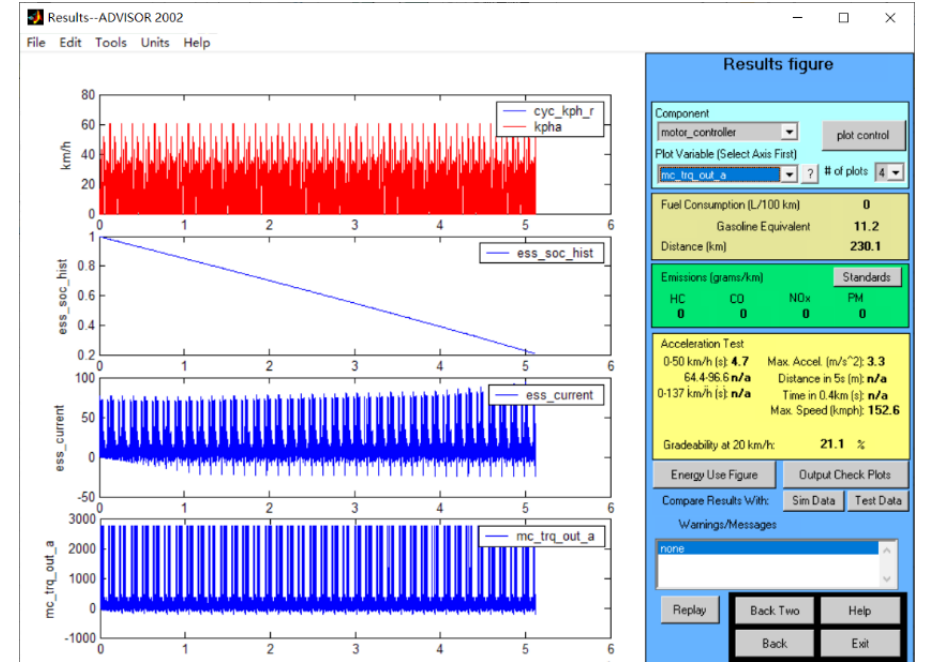
Figure 11. Simulation results of experiment 3.